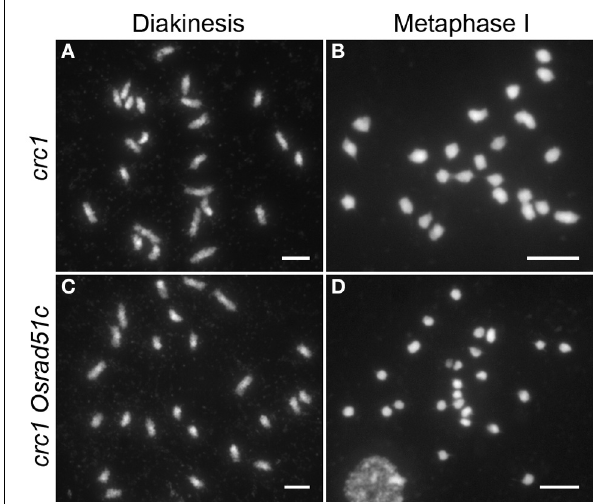
FIGURE 3 | Male meiosis in crc1 (A,B) and crc1 Osrad51c (C,D). (A,C) Diakinesis; (B,D) Metaphase I. Bars, 5 μ m.